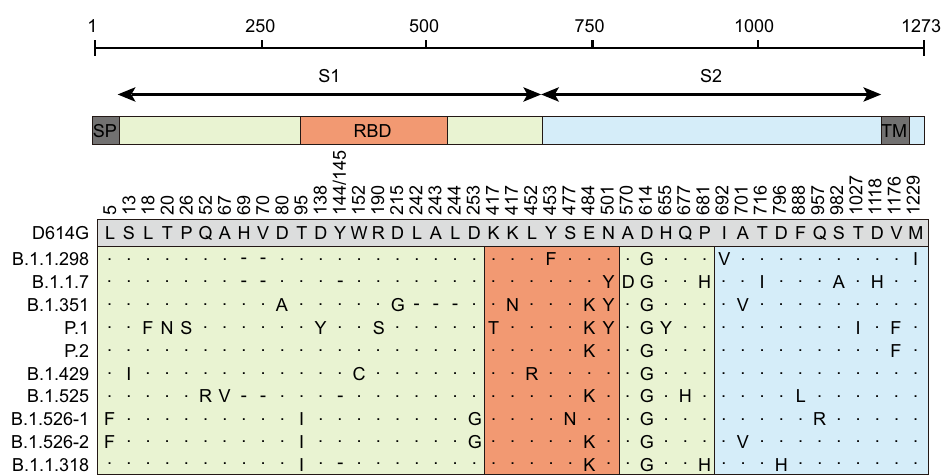
Fig. 1 Schematic of SARS-CoV-2 variants. The most representative amino acid mutations of each variant were selected to construct pseudotyped virus for this study. Each mutation in each SARS-CoV-2 variant is indicated relative to the reference D614G sequence. A dot indicates an identical amino acid at the indicated position, while a dash indicates a deletion at that point. SP sigmal peptide, TM transmembrane domain, RBD Receptor-binding